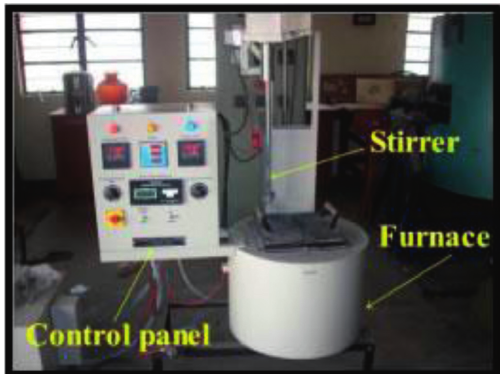
Figure 2: Bottom pouring stir